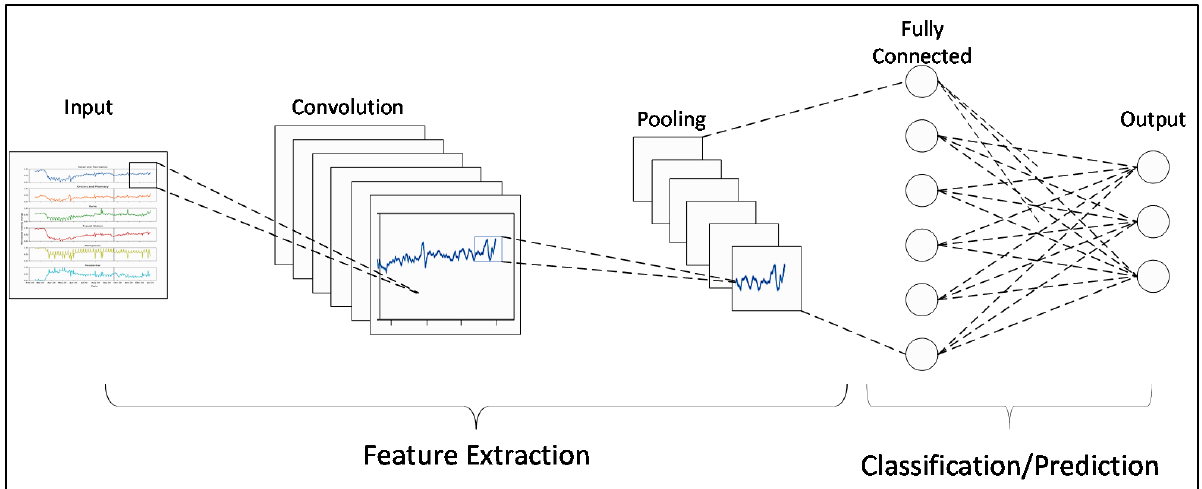
Figure 1. Illustration of feature extraction and prediction from time-series data by CNN when being applied on multivariate time-series data.